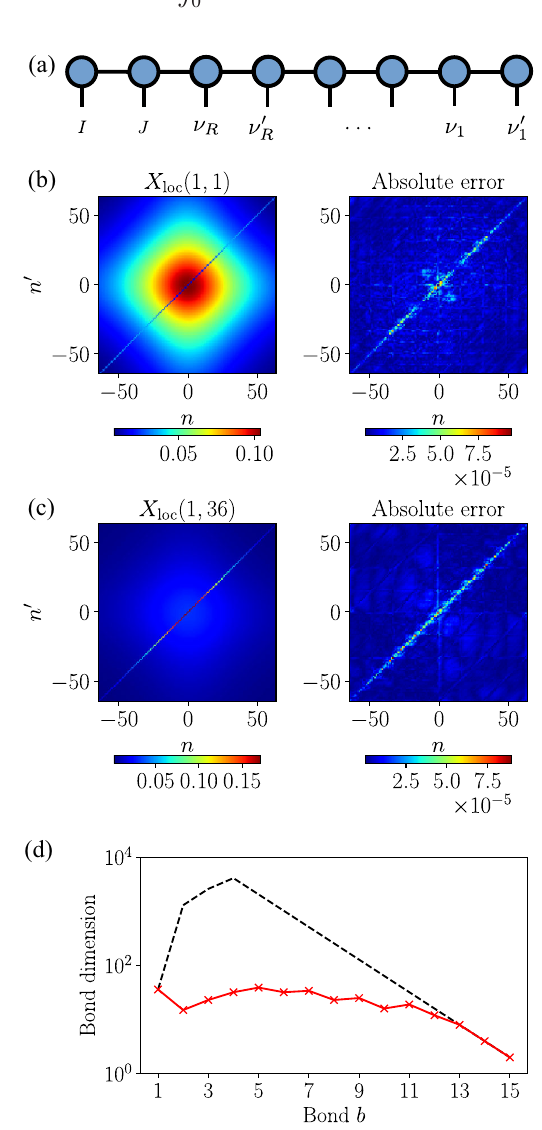
FIG. 17. Local generalized susceptibility of CeB 6 computed by DFT þ DMFT. (a) MPS, (b),(c) intensity map of the recon- and error for ϵ ¼ 10 − 8 , (d) bond dimensions along structed X loc the MPS. In (d), the dashed line indicates the maximum bond dimensions in maximally entangled cases. The estimated com- pression ratio is around